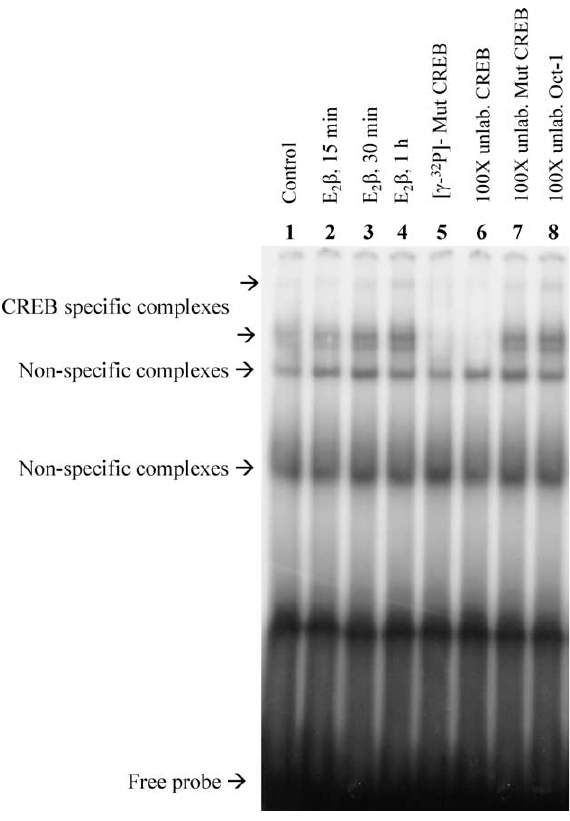
FIG. 2. E 2 b induces CREB activation in CCRF-CEM cells. The cells were treated with E 2 b (1 m M) (lanes 2 (cid:1) / 4), for 15 min, 30 min or 1 h, or left untreated (control, lane 1). Nuclear extracts were subjected to EMSA analysis as described in Materials and methods. Competition experiments with a 100-fold excess of unlabelled competitor probe relatively to the labelled CREB probe were C performed using the nuclear extracts from cells treated with E 2 b , for 30 min (lanes 6 (cid:1) / 8). EMSA analysis was also performed using a labelled mutant CREB probe (lane 5). The results shown are representative of three independent